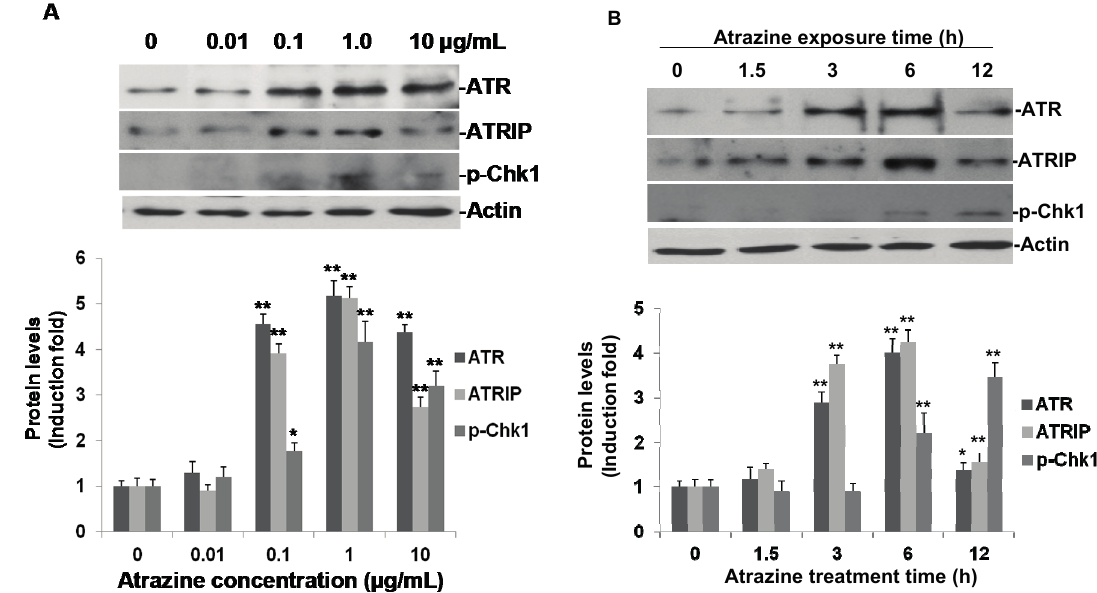
Figure 4. Atrazine-induced expression of ATR, ATRIP and phosphorylation of Chk1 (Ser317) in MCF-10A cells. ( A ) Dose-response of atrazine–induced ATR, ATRIP and p-Chk1. MCF-10A cells (3 × 10 5 ) were incubated with the indicated concentrations of atrazine for 6 h and analyzed by Western blot; ( B ) time course of atrazine-induced ATR, ATRIP and p-Chk1in MCF-10A cells. MCF-10A cells (3 × 10 5 ) were treated with 0.1 μ g/mL of atrazine for the indicated times and analyzed by Western blot. For each blot, the resulting fold-change of atrazine-mediated ATR, ATRIP and p-Chk1 expression over DMSO untreated controls is provided in the corresponding histogram ( n = 3) with the signal normalized to actin as a loading control. * p < 0.05, ** p < 0.01 vs.